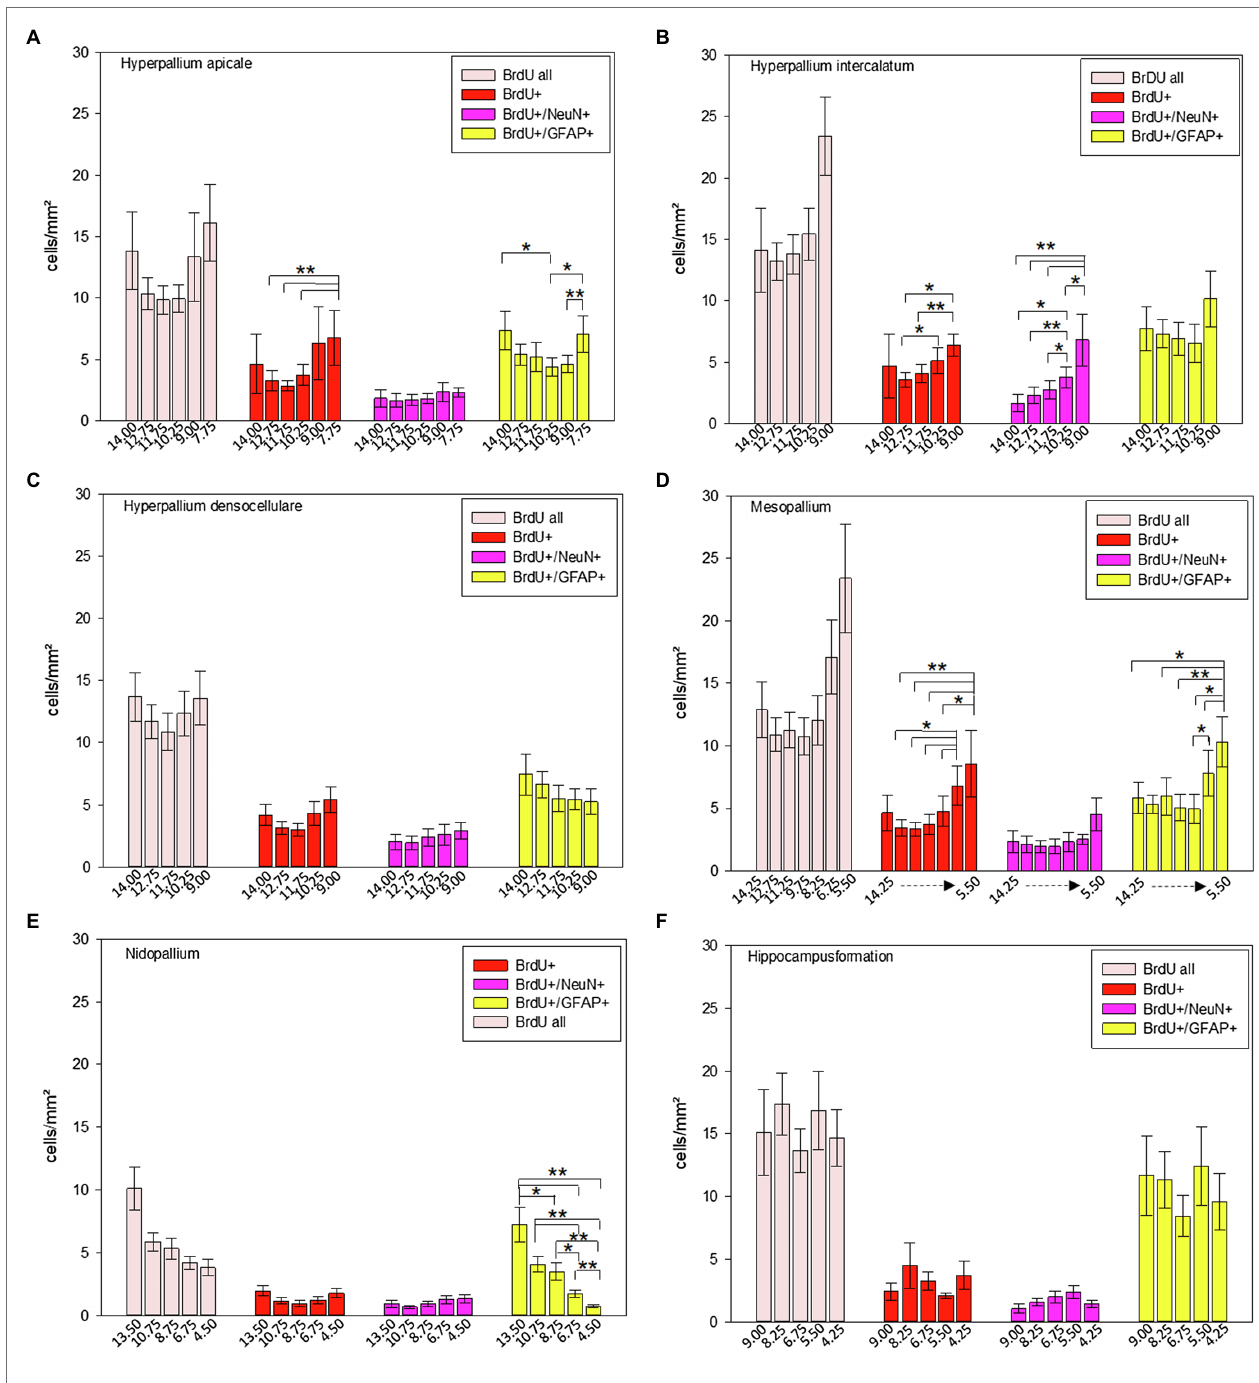
FIGURE 10 | Distribution of BrdU+, BrdU+/NeuN+ and BrdU+/GFAP+ cells/mm 2 of different atlas levels along the anterior–posterior axis in different regions of the pigeon ( n = 9). (A) Hyperpallium apicale, (B) Hyperpallium intercalatum, (C) Hyperpallium densocellulare, (D) Mesopallium, (E) Nidopallium, (F) Hippocampal formation. “BrdU all” means the sum of all BrdU labelled cells (single and double labelled). Atlas level A13.50 in nidopallium represents NF, A10.75 and A8.75 NI and A6.75 and A4.50 NC. Bars represent mean ± SE. Asterisks indicate significant differences (Wilcoxon Signed Rank Test, * p < 0.05, ** p <